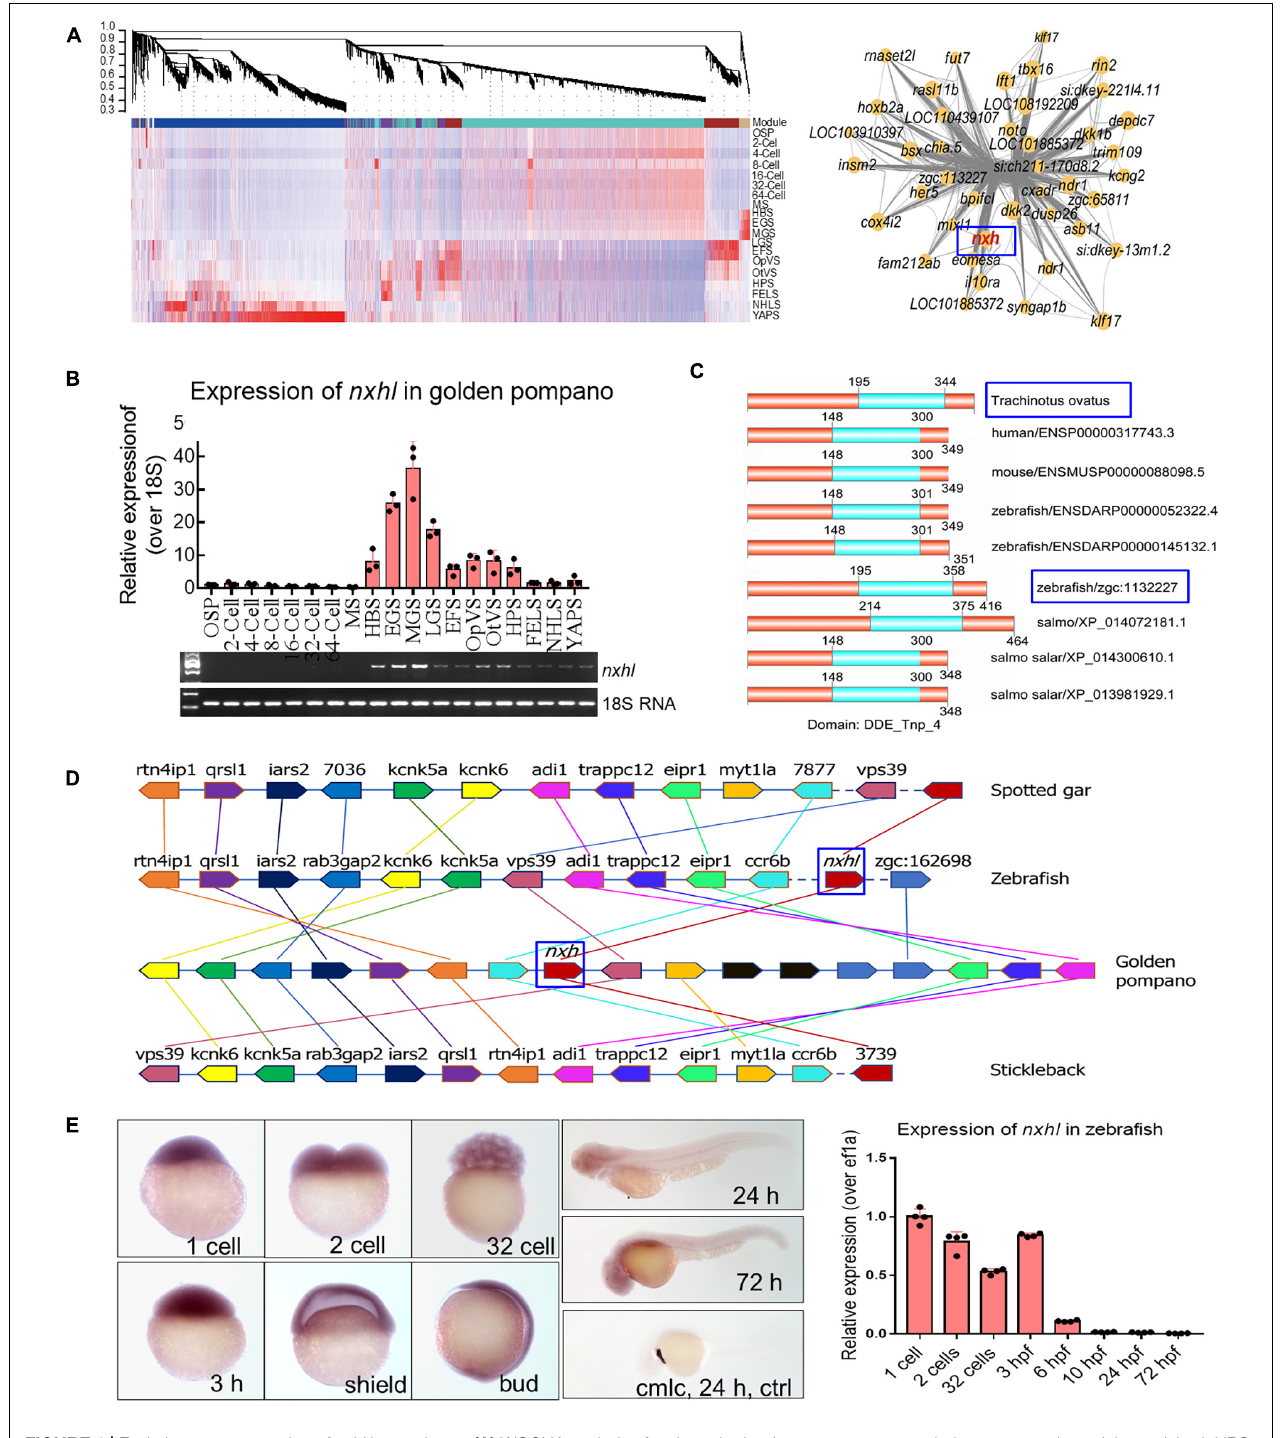
FIGURE 1 | Evolutionary conservation of nxhl in vertebrate. (A) WGCNA analysis of embryonic development stages revealed gene-network modules enriched. HBS, EGS and MGS are classified into one group. OSP, oosperm; MS, morula stage; HBS, high blastula stage; EGS, early gastrula stage; MGS, middle gastrula stage; LGS, late gastrula stage; EFS, embryo formed stage; OpVS, optic vesicle stage; OtVS,otocyst vesicle stage; HPS, heart pulsation stage; FELS, formation of eye lens; NHLS, newly hatched larvae; YAPS, yolk absorption period. (B) Validation of expression level for nxhl by qPCR technology. 18s RNA was considered as internal marker. Gene structure of nxhl was showed at upper region. (C) Domains of nxhl and other homologous protein. The domain DDE_Tnp_4 was identified in SMART database (http://smart.embl.de/). (D) Micro-synteny analysis of nxh locus among spotted gar, zebrafish, gold pompano and stickleback. Two inversions and one insertion occurred in nxh locus region of golden pompano genomes. (E) The distribution of nxhl in zebrafish embryo by using whole-mount embryo in situ hybridization (WISH) and qPCR. Cmlc was used as positive control. Nxhl is mainly distributed in maternal developmental stages in zebrafish embryo.